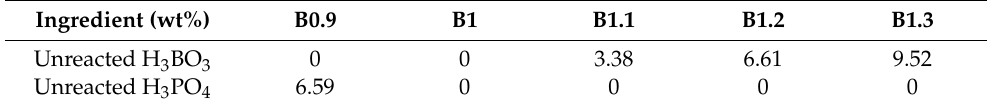
Table 2. The content of H 3 BO 3 and H 3 PO 4 that theoretically unreacted.